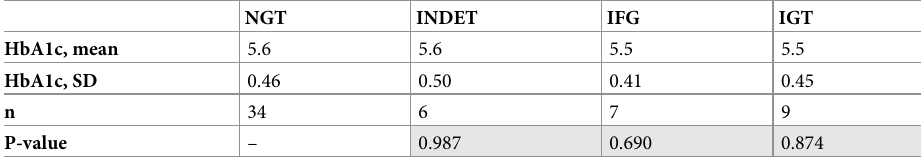
Table 2. Hemoglobin A1c values of the four glycemic state groups.